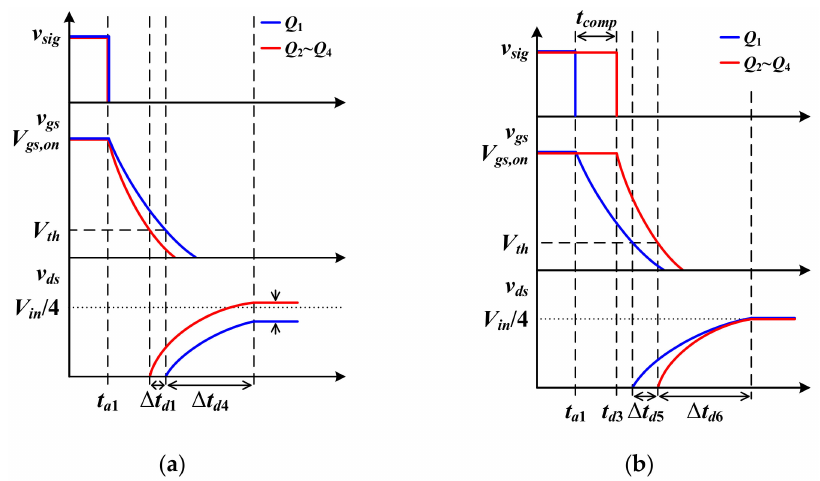
Figure 8. Turn-o ff switching waveforms: ( a ) without proposed switching scheme; ( b ) with proposed switching